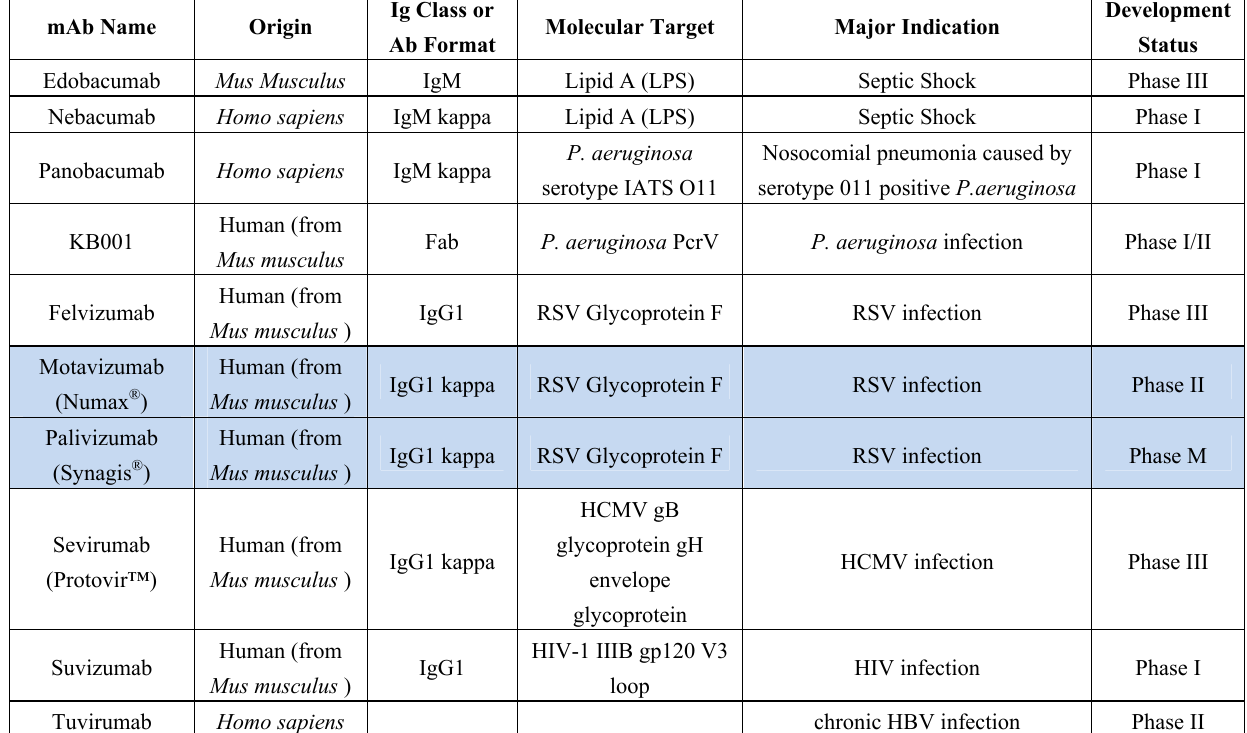
Table 2. Examples of clinical trials involving anti infectious monoclonal antibodies (mAbs); Light blue boxes highlight phage display-derived or optimized